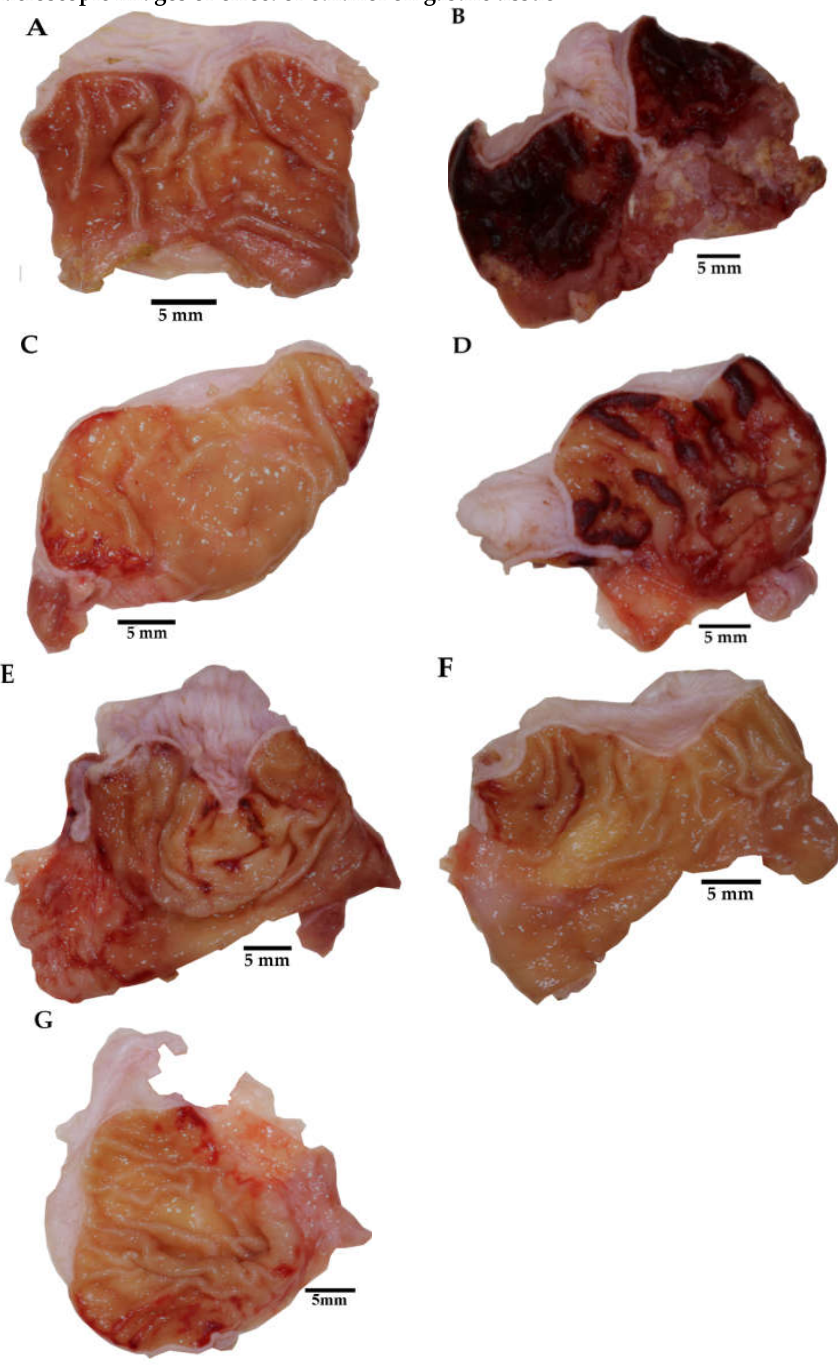
Figure 4. Photographic images show a representative stomach from each experimental group. ( A ) Healthy = rat without gastric lesions, ( B ) Veh = rat with gastric ulcers, ( C ) L -Arg = L -arginine, ( D ) MaSS = 30 mg/kg, ( E ) MaSS = 90 mg/kg, ( F ) MaSS = 120 mg/kg, ( G ) MaSS = 180 mg/kg is a mixture of kaempferol 3- O -sophoroside and kaempferol 3- O -sambubioside.